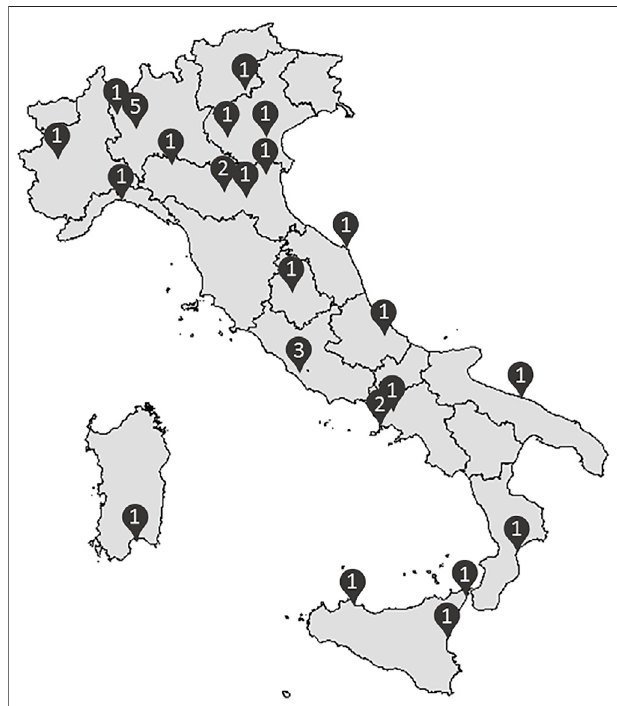
FIGURE 1 | Distribution of the 31 Italian lipid clinics involved in the LIPIGEN pediatric group (number of